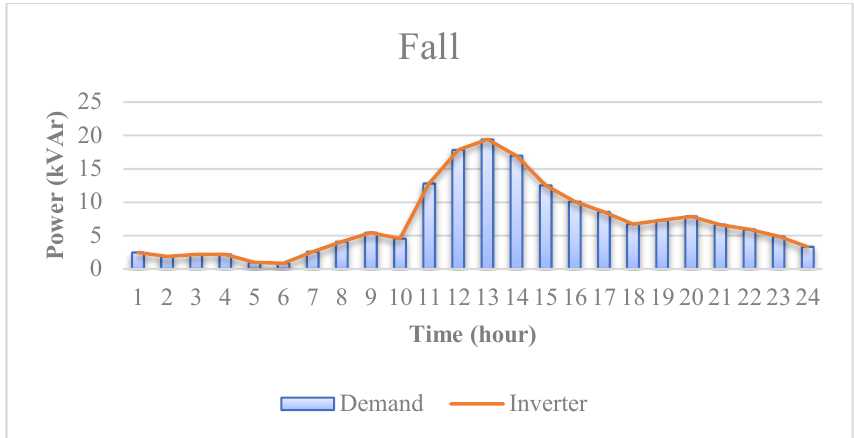
Figure 12. The bidding power of the VPP in fall.